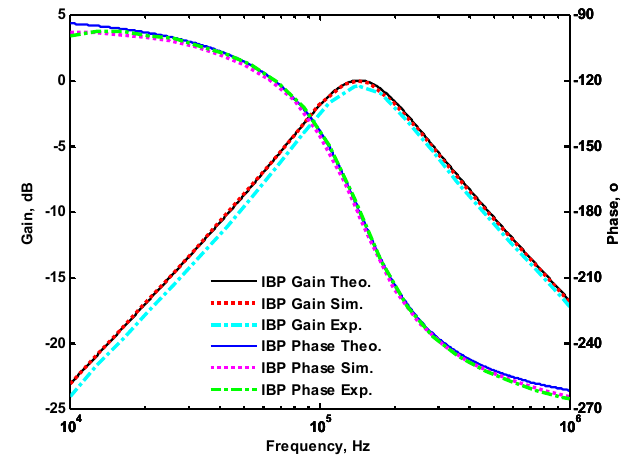
Figure 7. Experimental and simulated low-pass (LP) filters with theoretical responses.